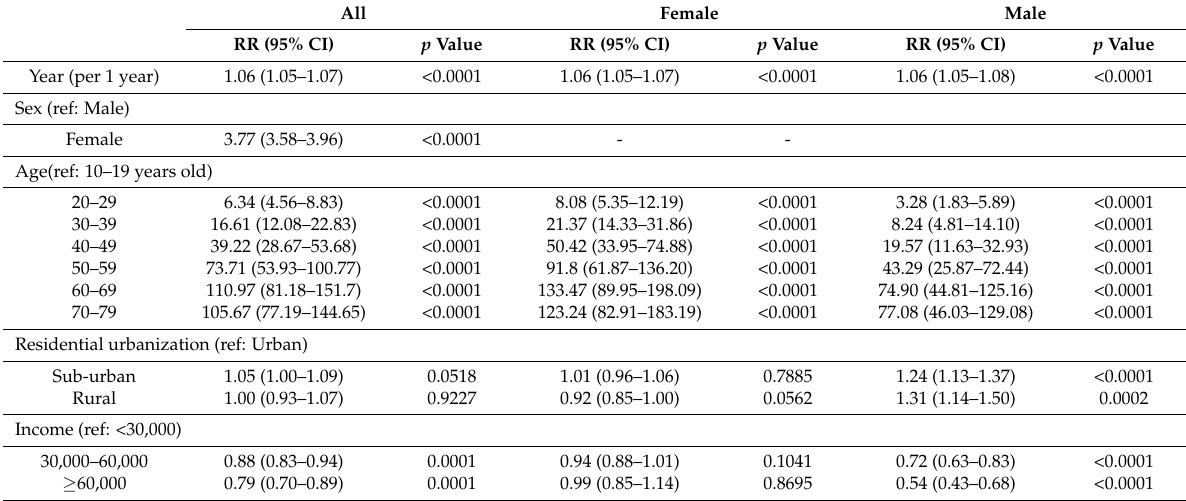
Table 2. Relative risk of prevalent cases of Rheumatoid Arthritis in Taiwan from 2001 to 2011 by using multiple Poisson regression